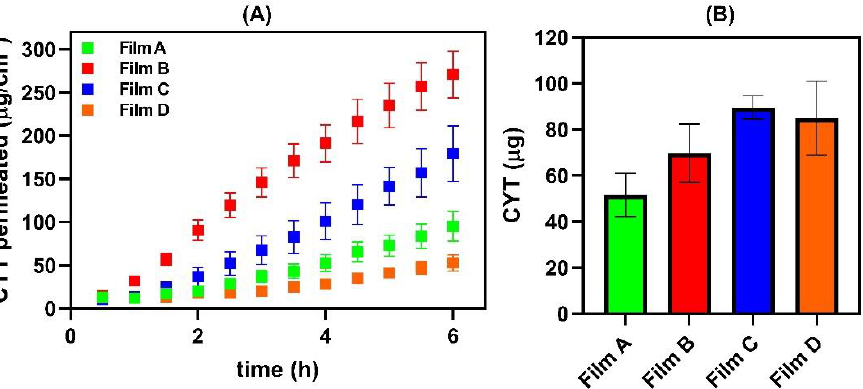
Figure 8. ( A ) CYT (mg/cm 2 ) permeated as a function of time (h). ( B ) Amount ( µ g) of CYT accumu- lated into the buccal membrane (0.636 cm 2 ) after 6 h of experiment applying Film A (green), Film B (red), Film C (blue) and Film D (orange). Results are presented as means ± SE ( n = 6). As expected, the presence of xylitol (Film B and C) positively affected the permeation profiles, producing higher drug fluxes than those observable for the xylitol-free films. In contrast, the accumulation into the tissue is higher in presence of PVP K90.